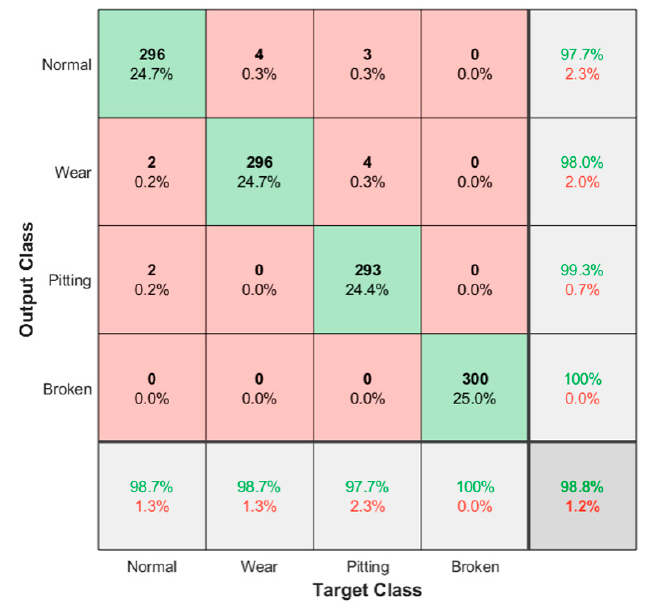
Figure 11. Confusion matrix of the fifth operation recognition result.